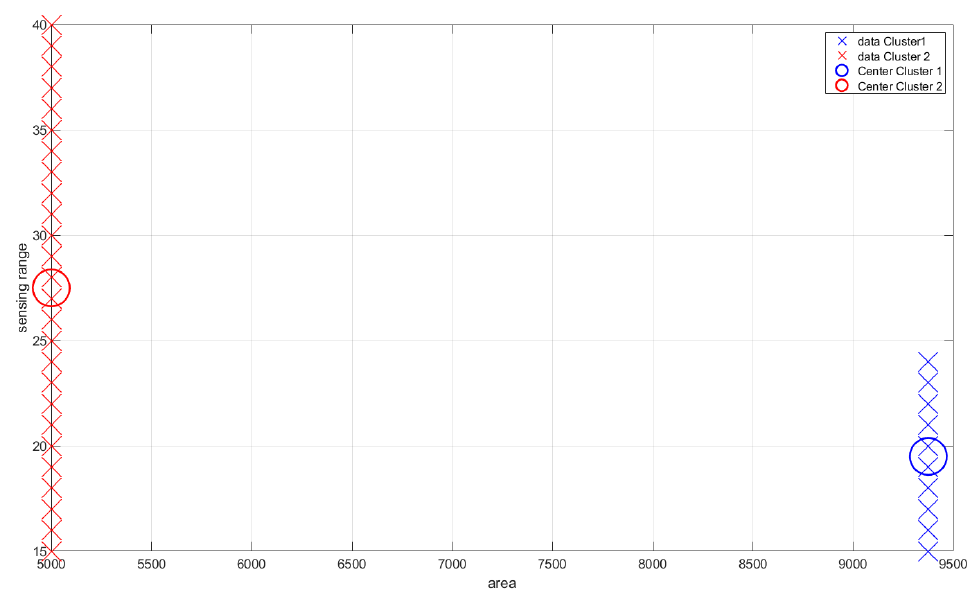
Figure 9. Initial result of data fuzzification (relation area versus sensing range).